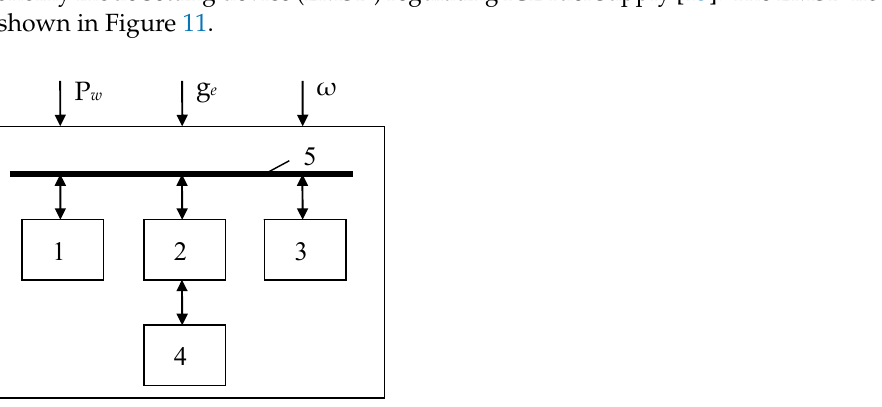
Figure 11. Flowchart of the economy mode setting device (EMSD). Reprinted with permission from Ref. [15]: learning controller (1); management controller (2); content ‐ addressable memory block (3);